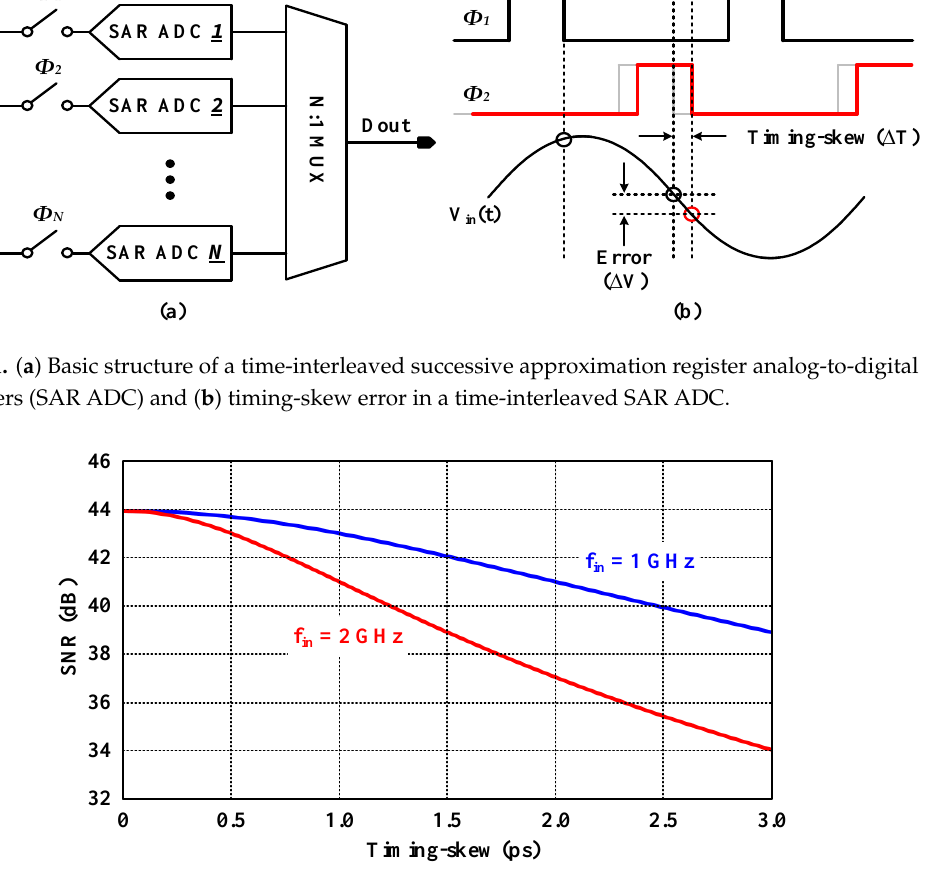
Figure 2. Signal-to-noise ratio (SNR) degradation of the 7-bit time-interleaved ADC due to the timing skews.